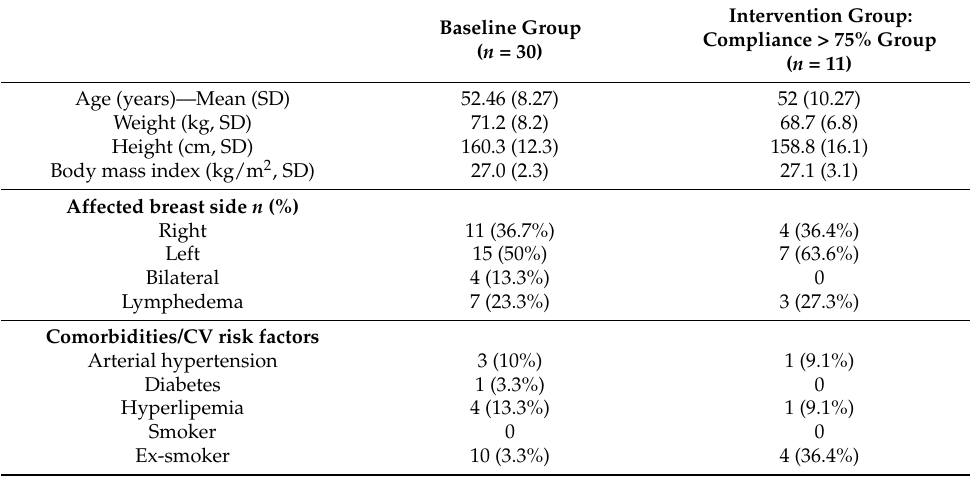
Table 1. Patients’ clinical variables at baseline.